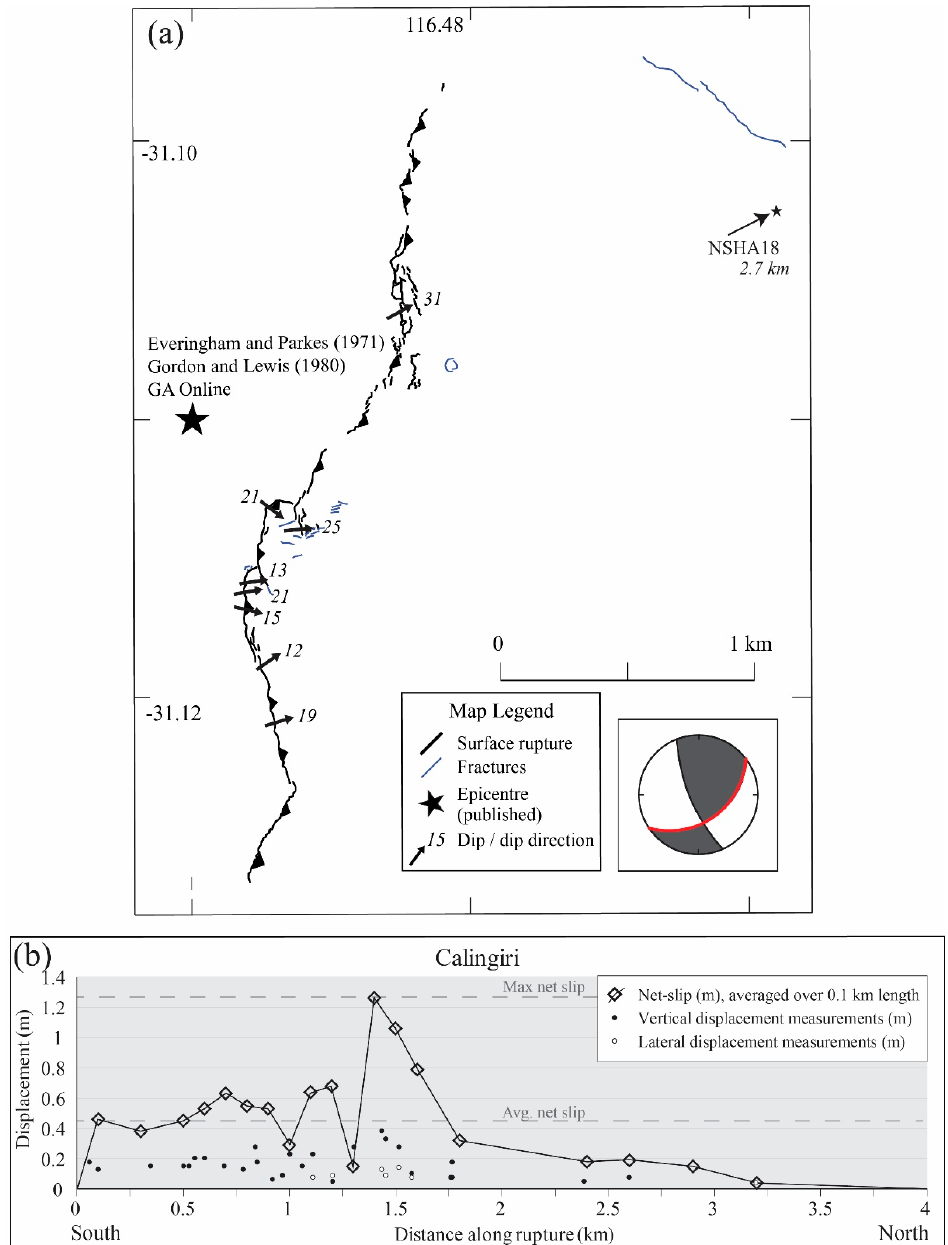
Figure 4. 1970 Mw 5.0 Calingiri earthquake ( a ) rupture and fracture map of Calingiri [25] showing published epicenter locations and dip measurements of scarp [25], focal mechanism (red line shows preferred plane from original publication) from Fitch et al., 1973 ( b ) graph of along-rupture vertical and lateral displacement measurements [25] and net slip calculated from available data averaged over 0.1 km increments (this study).